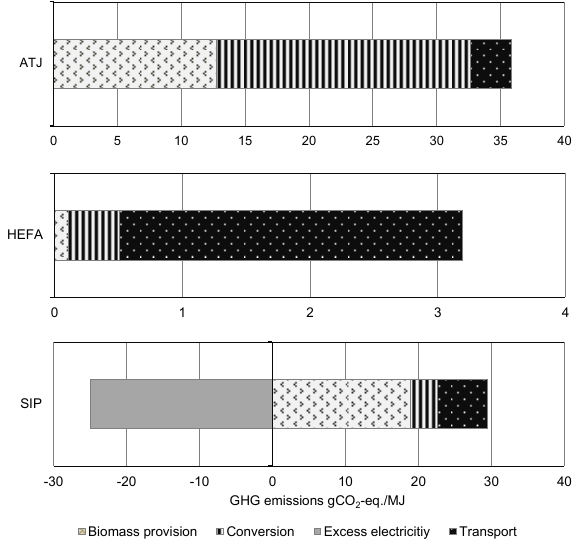
Figure 4. Specific GHG emissions of the investigated sustainable aviation fuels (SAF). For readability purposes, the x -axis displaying GHG emissions from HEFA production is enlarged by a factor of 10.